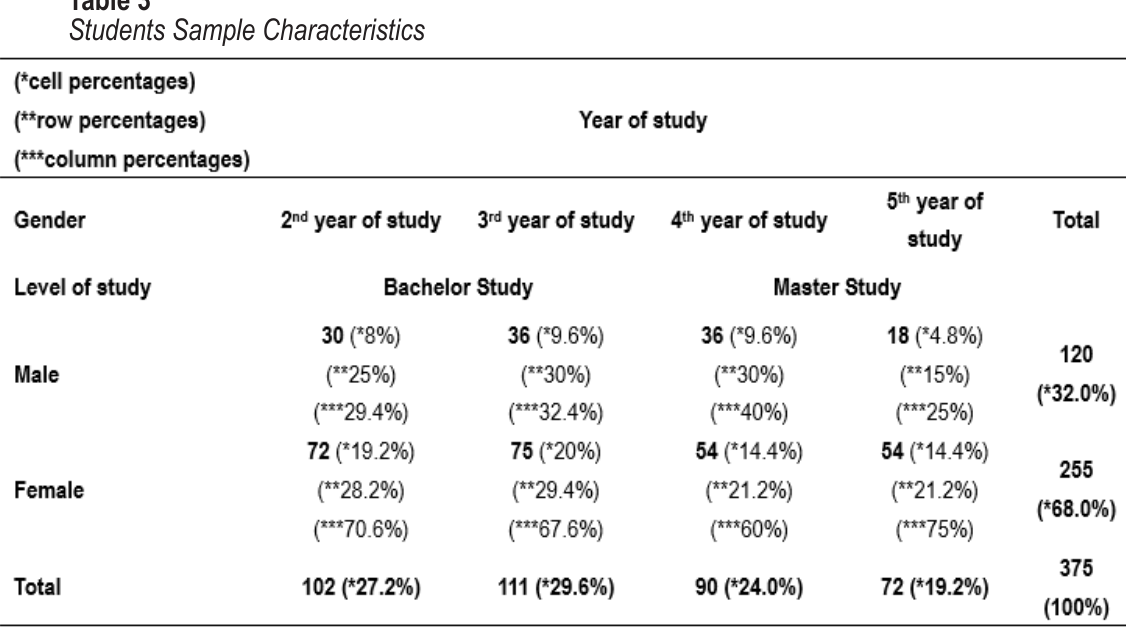
Students Sample Characteristics